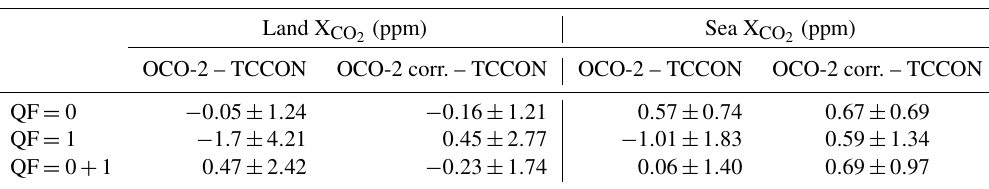
Table 5. Mean and standard deviation of bias in X CO compared to TCCON observations for the testing set (August 2018–July 2019). The 2 comparison for the operational OCO-2 product is indicated by OCO-2 – TCCON and the proposed random forest approach by OCO-2 corr. – TCCON.